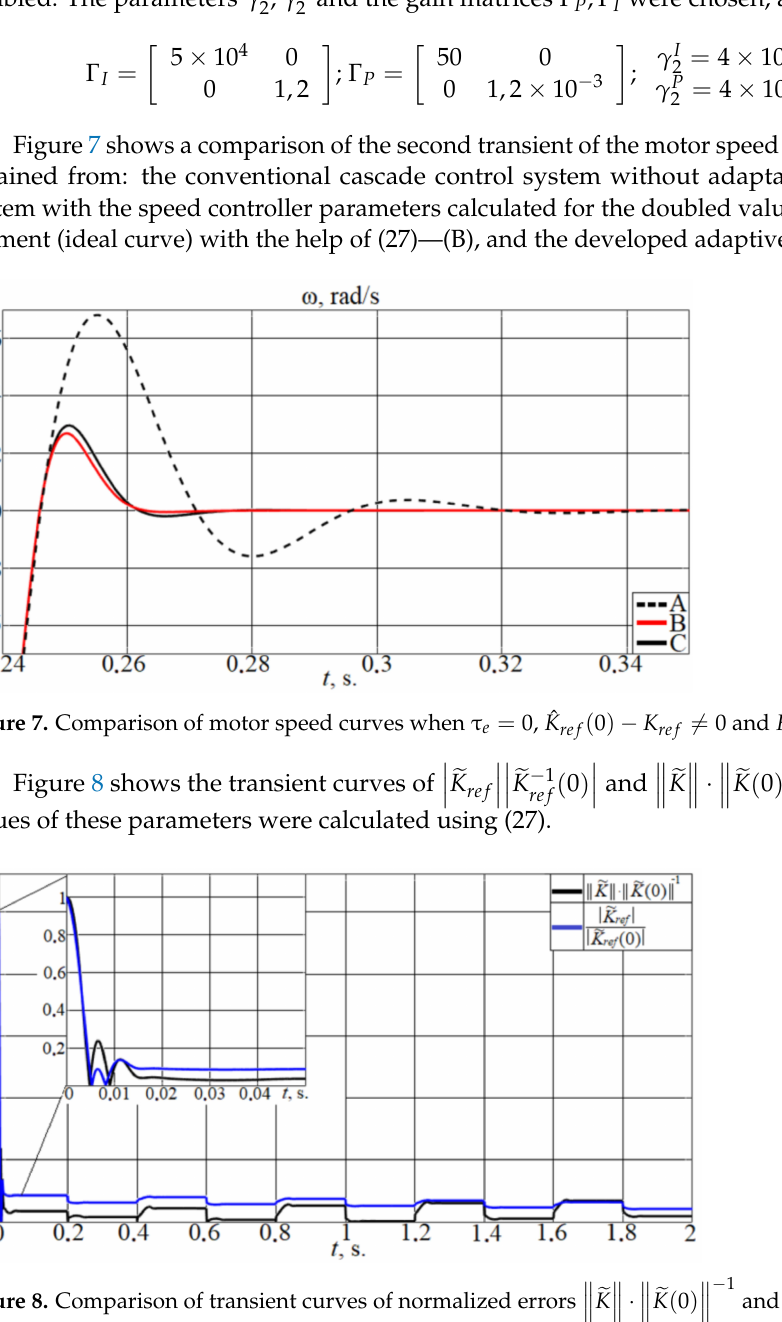
Figure 8. Comparison of transient curves of normalized errors